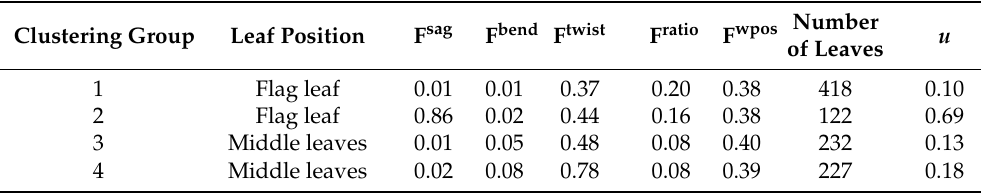
Table 3. The central value of leaf clusters (Figure 3) based on five morphological parameters of leaves. Note: u is the similarity for further leaf matching, see Equation